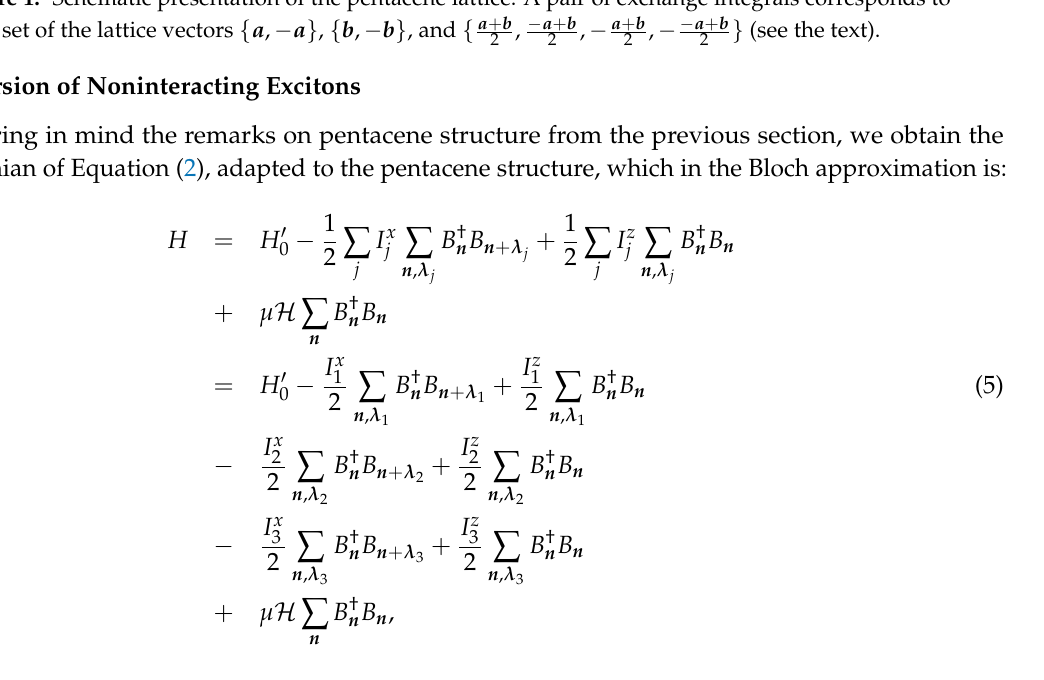
} (see the , − a + b , − a + b , − − a + b 2 2 2 2